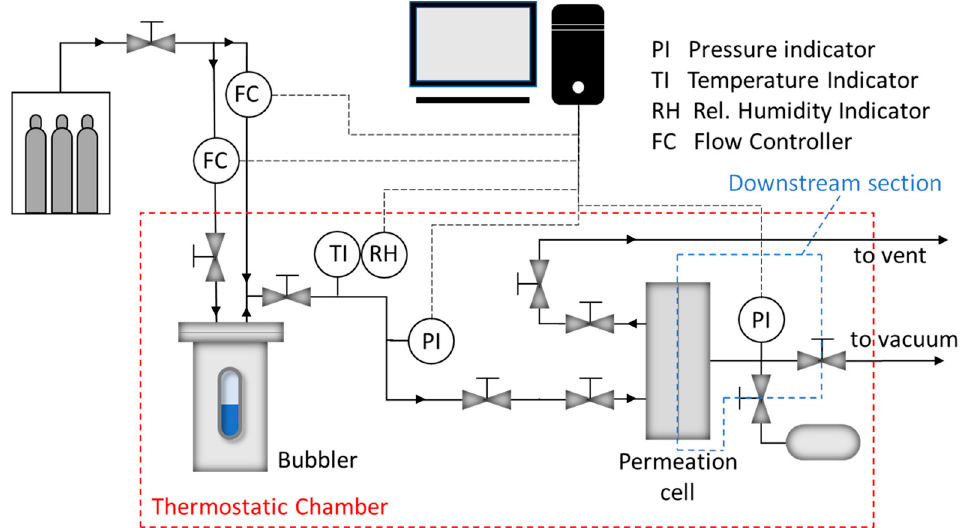
Figure 2. Schematic of the permeation equipment used for testing.